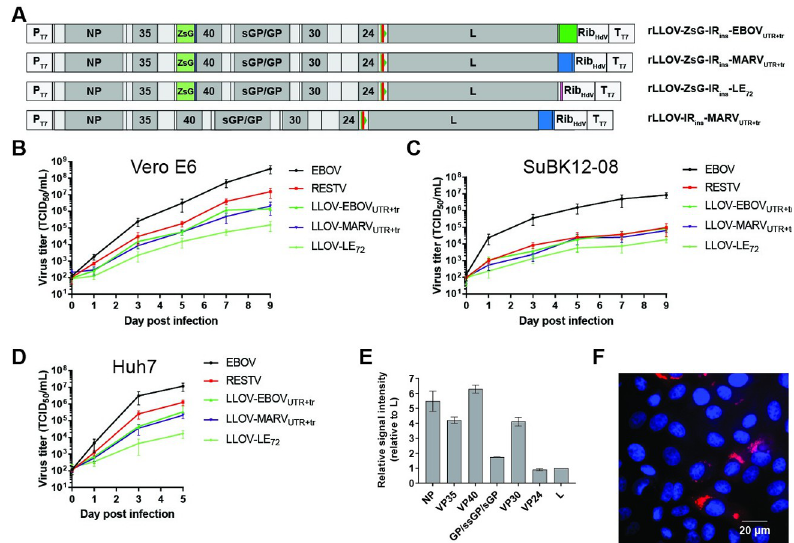
Fig 2. rLLOV comp rescue. (A) Schematics of successfully rescued rLLOV comp full-length clones. Noncoding regions are indicated in light gray, LLOV ORFs are in gray, a ZsGreen-P2A reporter (ZsG) is in light green, red bars and green triangles indicate the GE and GS signals in the IR ins insertion in the VP24-L intergenic region, green indicates EBOV sequences (EBOV UTR+tr ), pink indicates short EBOV trailer sequences (LE 72 ) and blue indicates MARV sequences (MARV UTR+tr ). rLLOV comp clones are to scale except the T7 RNA polymerase promoter (P T7 ), hepatitis δ ribozyme (Rib HdV ), T7 RNA polymerase terminator sequences (T T7 ), and IR ins , which are enlarged for clarity. (B-D) Growth curve of rEBOV, rRESTV, and the indicated versions of rLLOV comp using an initial MOI of 0.1 in Vero E6 (B), SuBK12-08 (C), and Huh7 cells (D). (E) Proteomic analysis of LLOV proteins expressed in SuBK12-08 cells infected with rLLOV-ZsG-IR ins -EBOV UTR+tr at a multiplicity of infection (MOI) of 1 at two days post-infection (dpi). Signal intensities of viral proteins are plotted relative to L signal intensity within the same sample. (F) RNA FISH analysis of Vero E6 cells infected with rLLOV-IR ins -MARV UTR+tr at an MOI of 1 at 1 dpi. Red, negative sense genomic LLOV RNA clustered in viral inclusions. Cell nuclei were stained with DAPI